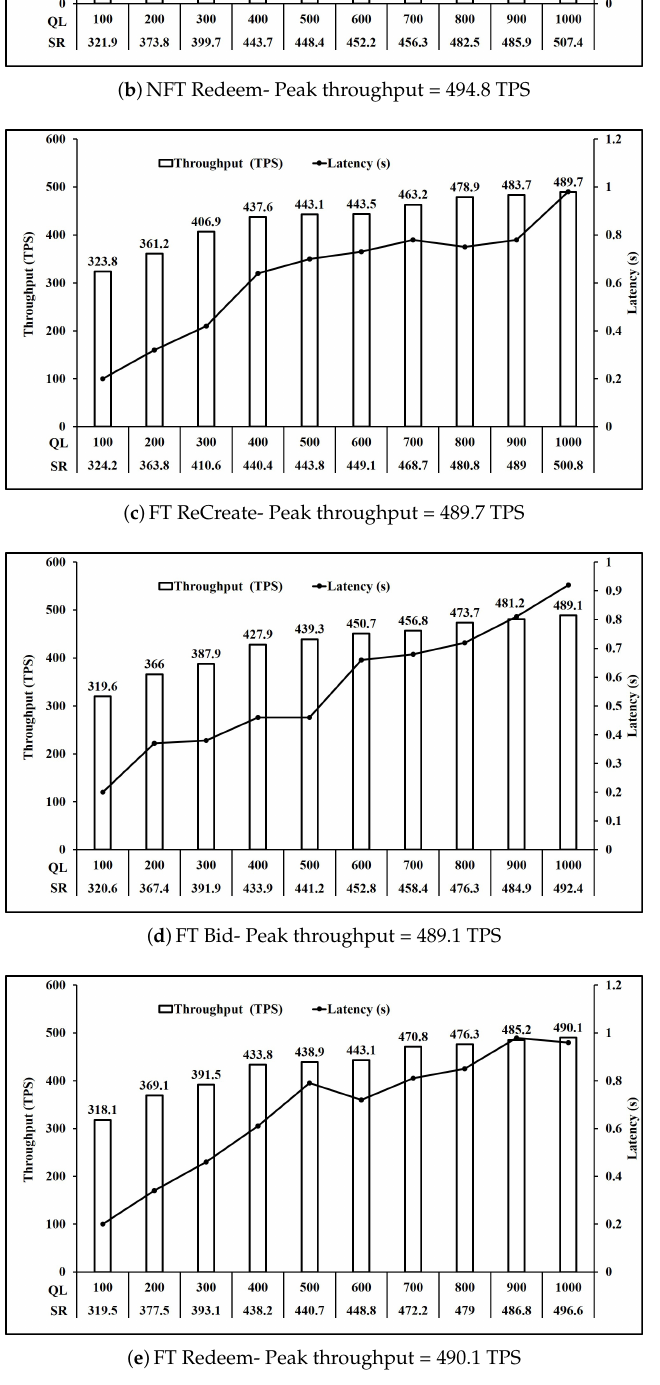
Figure 6. Operations with one write key operation (Queue Length: QL, Send Rate (TPS):